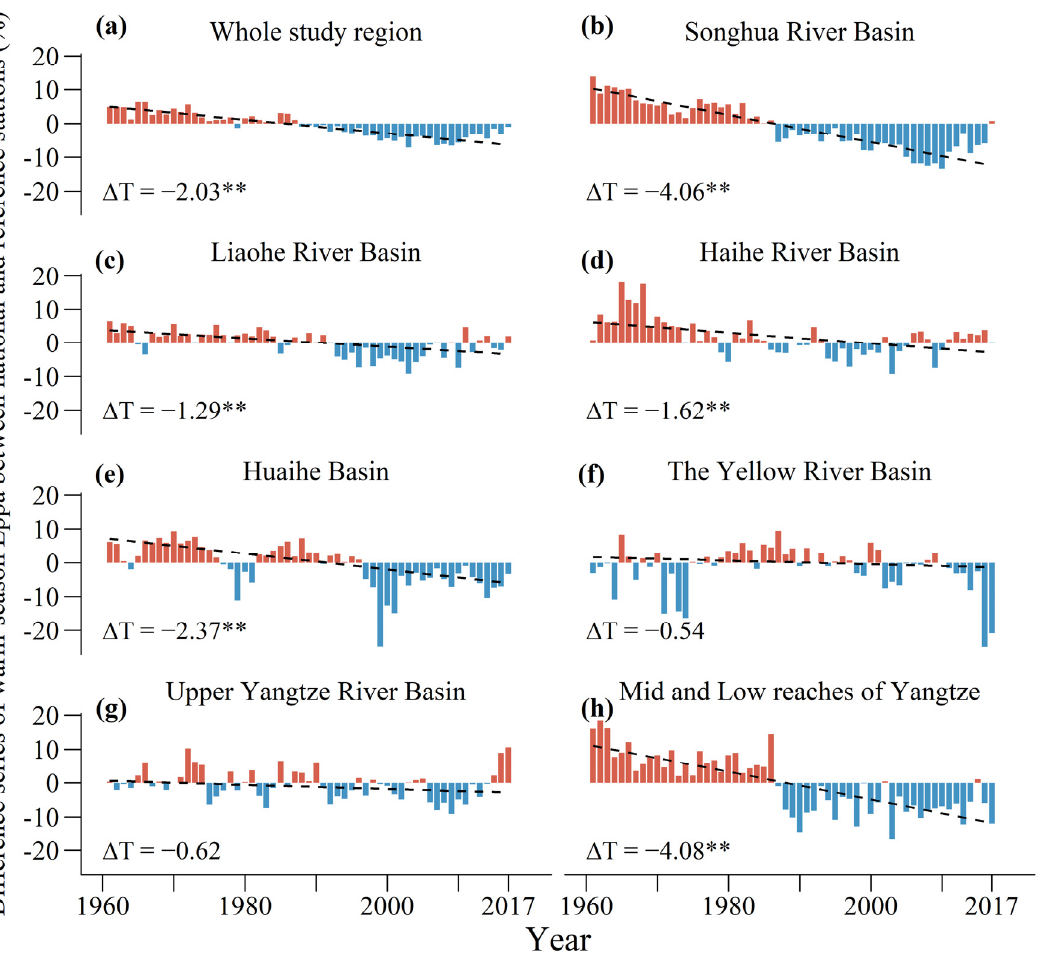
Figure 3. Difference series of warm-season (May to September) percent pan-evaporation anomaly (E ppa ) between urban and reference stations in each river basin (dash line indicates linear trends ( ∆ T, unit: %/decade); * and ** denote that trend was statistically significant at 0.05 and 0.01 levels).